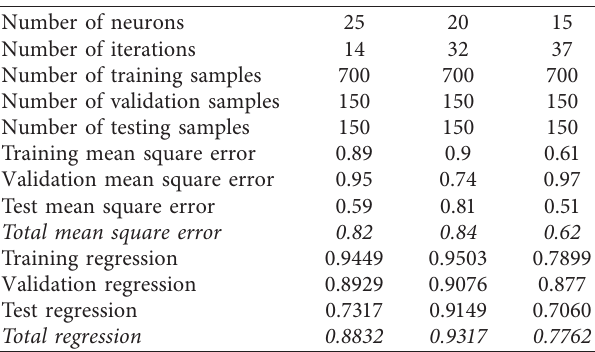
Table 6: Neural network training results for RPR arm.